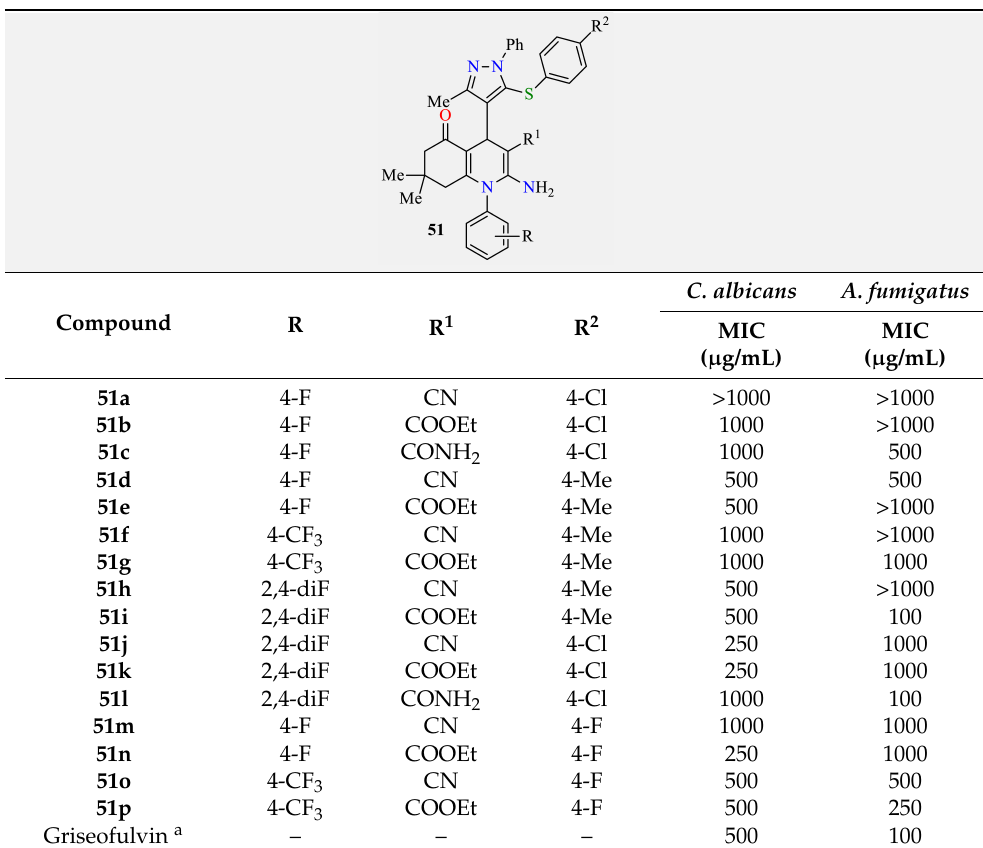
Table 38. Antifungal activity of polyhydroquinoline derivatives 51